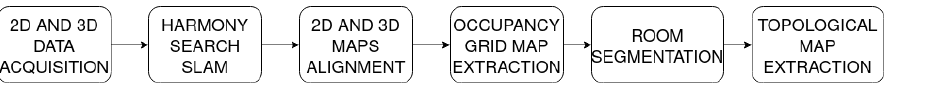
Figure 1. Proposed steps for creating a Multi-LiDAR mapping system and extracting a topological map